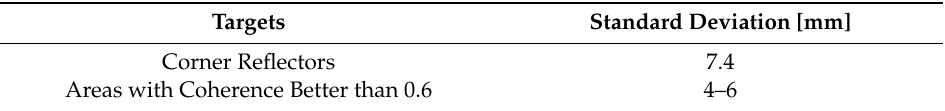
Table 4. Deformation map error overview, considering both deformation maps—right column: standard deviation of the deformation map error.